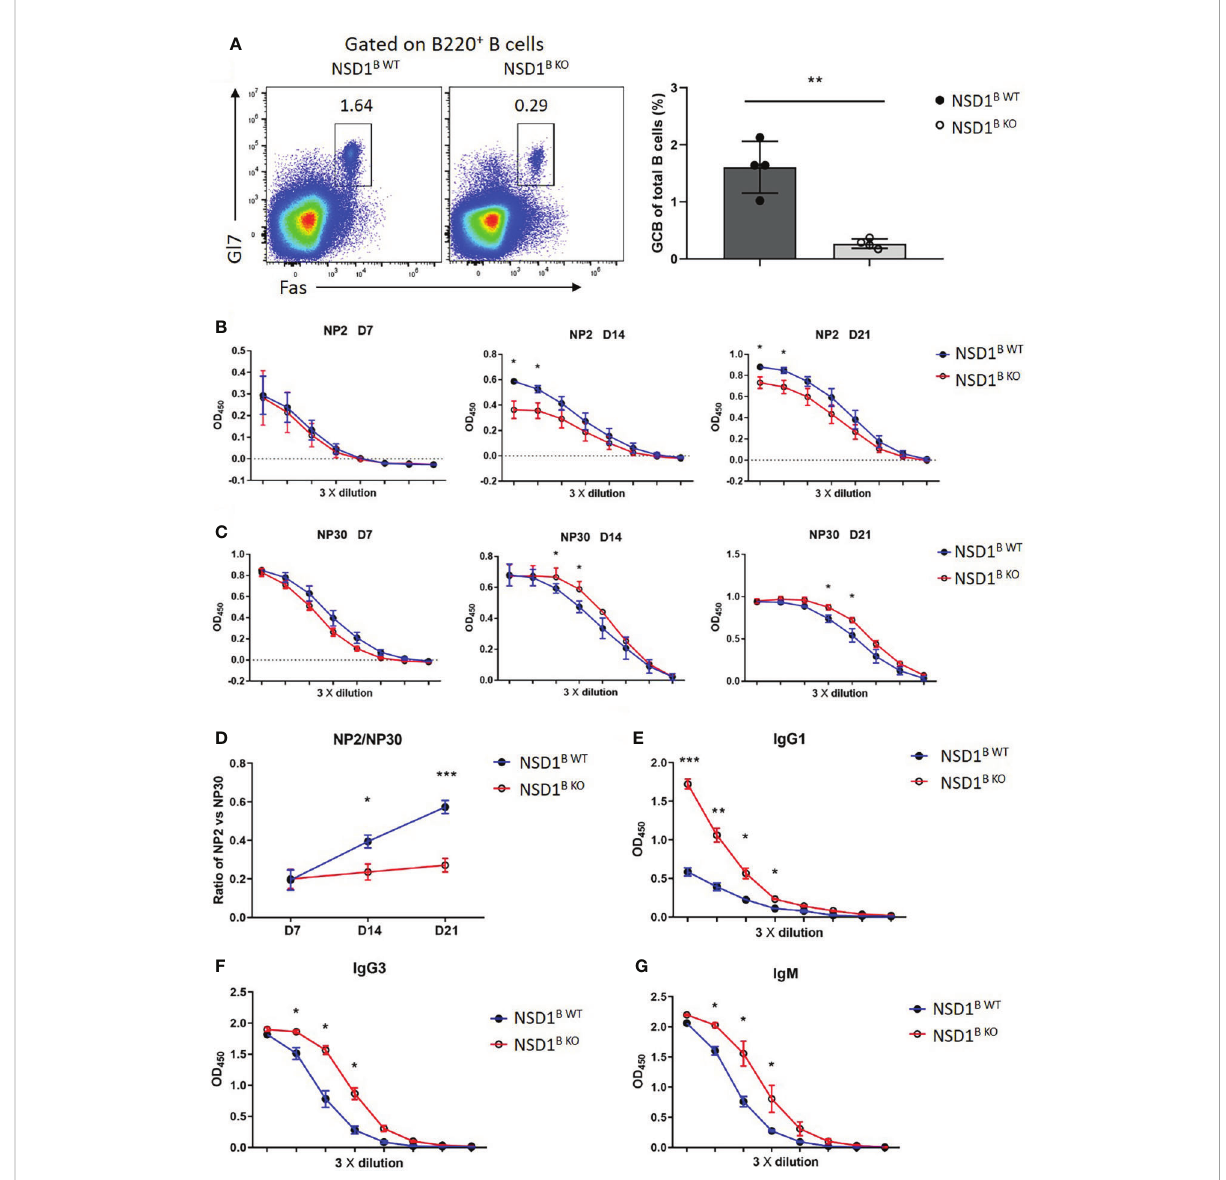
FIGURE 3 Loss of NSD1 affected the production of high- or low-af fi nity antibodies (A) . Germinal center B (GC B, B220 + Gl7 + Fas + ) cells in the spleen from NSD1 B WT and NSD1 B KO mice 21 days after NP-KLH immunization. (n = 4). (B, C) . NP2-speci fi c (B) and NP30-speci fi c (C) IgG antibody in serum were measured at day 7, 14 and 21 after NP-KLH immunization. Quanti fi cation data are shown as mean ± SD. (D) . Ratios of NP2/NP30 were calculated with raw optical density (OD) value in linear range. Statistical analysis was done with two-way ANOVA. (E) . T cell independent NP30- speci fi c IgG1 antibody in serum was measured at day 7 after NP-Ficoll immunization. Quanti fi cation data are shown as mean ± SD. (F, G) . T cell independent IgG3 and IgM antibody in serum were measured at day 7 after NP-Ficoll immunization. Quanti fi cation data are shown as mean ± SD. * P < 0.05, ** P < 0.01 and *** P <